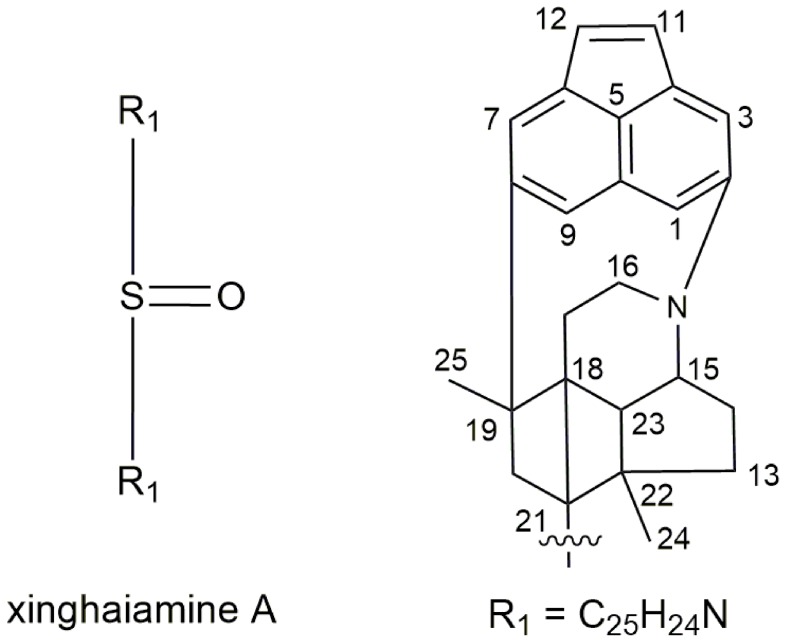
Proposed chemical structure of xinghaiamine A.